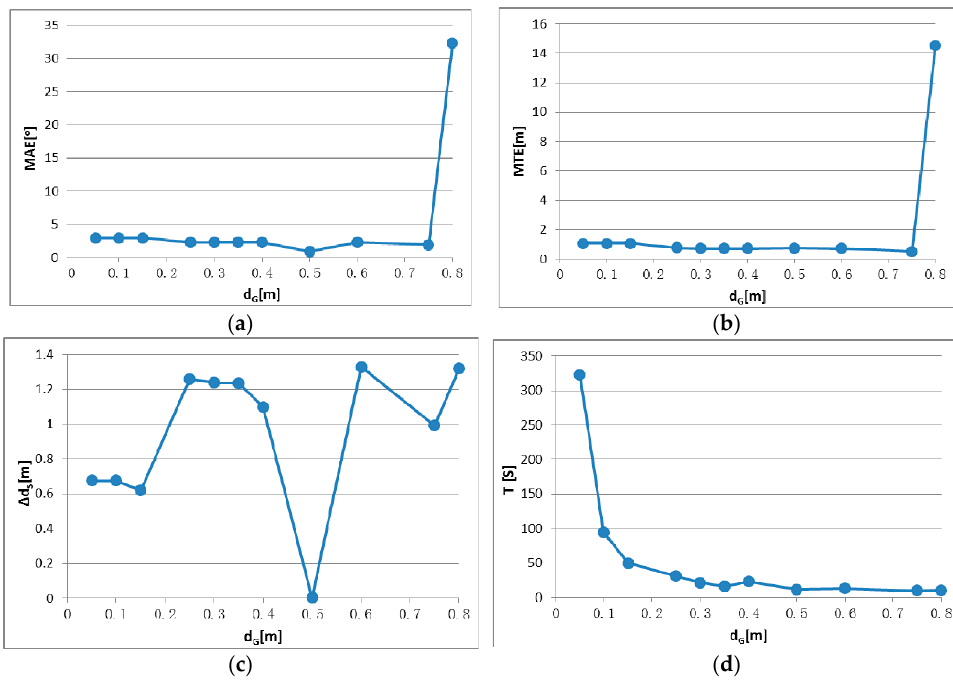
Figure 14. IME results with different d G , when t G is fixed to 2.5 m: ( a ) mean angular error (MAE); ( b ) mean translation error (MTE); ( c ) scan distance error ( ∆ d S ); and ( d ) runtime (T).